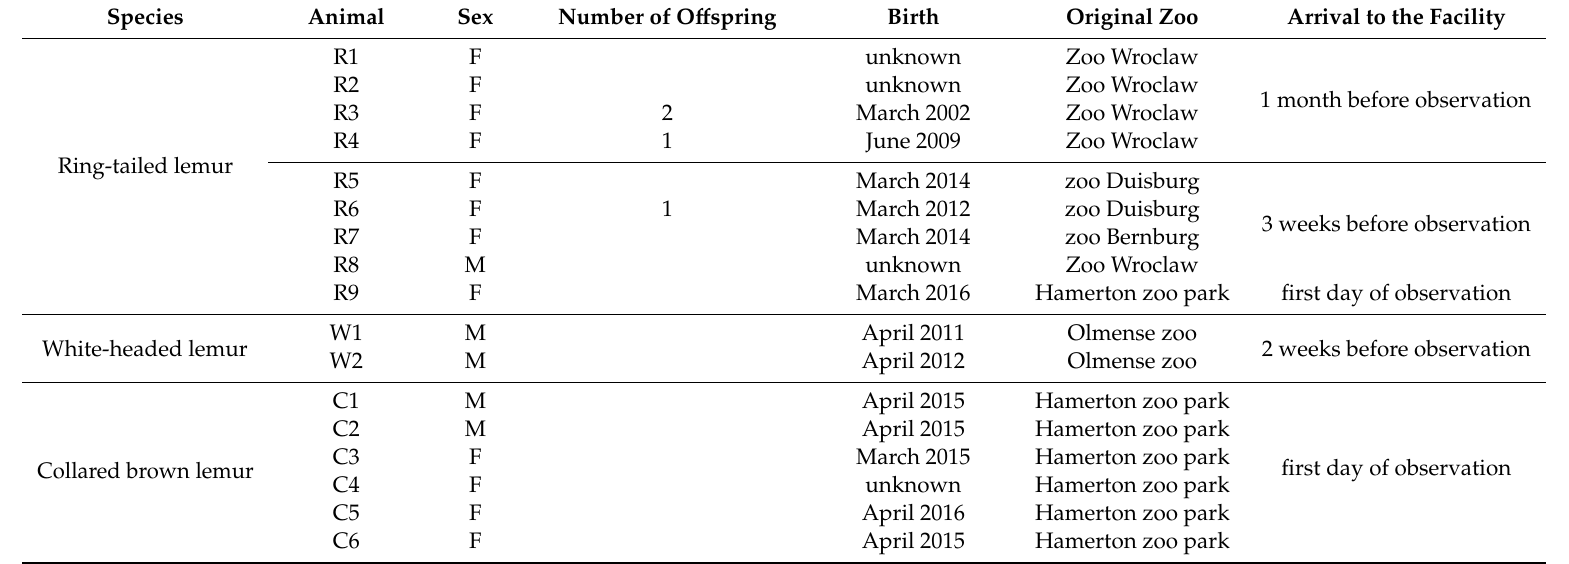
Table 1. Lemurs observed in a temporary housing